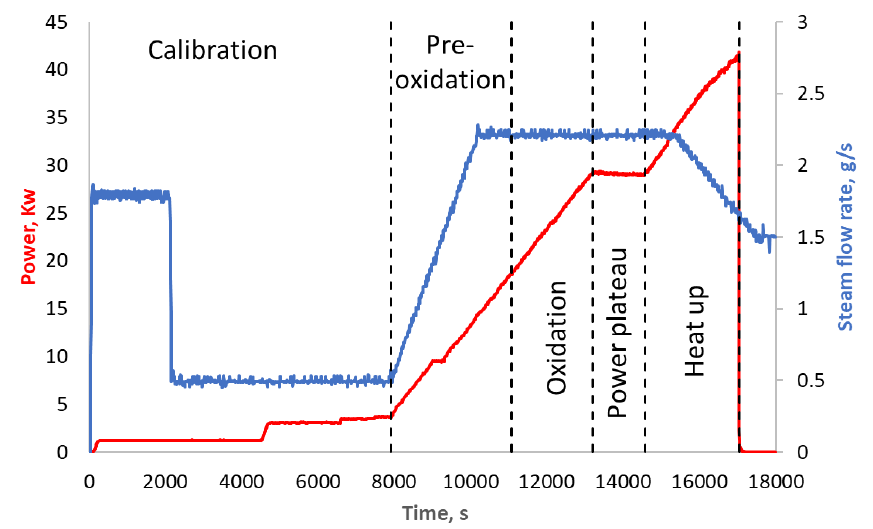
Figure 2. Radial cross-section of the FPT-1 test bundle [11].